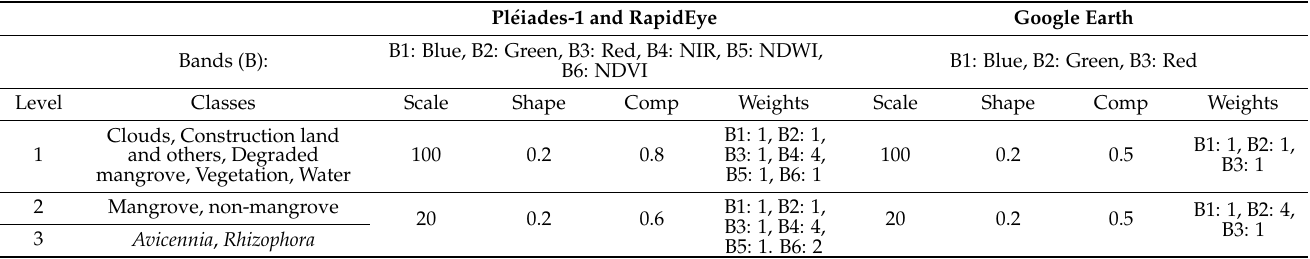
Table 1. Parameter settings for multi-resolution segmentation (segmentation scale, shape, compact- ness, and band weights) of high-resolution